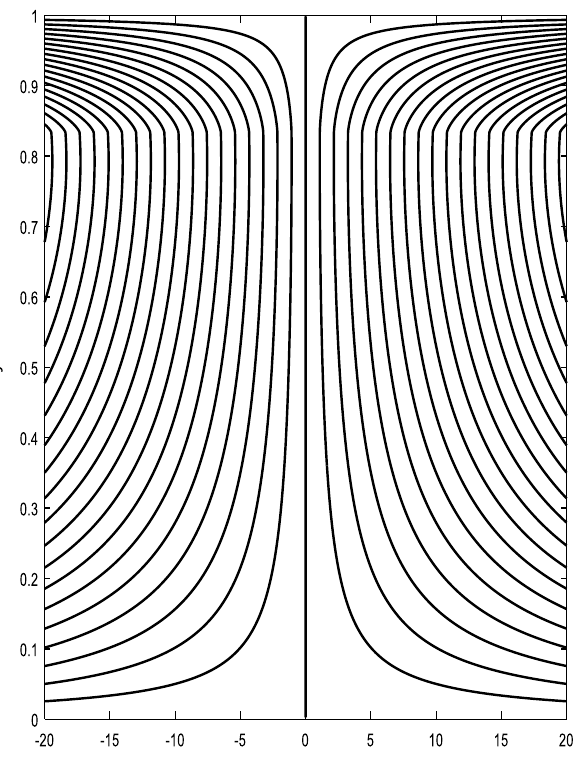
Figure 37. Stream lines profile at F = 0.6 and M =